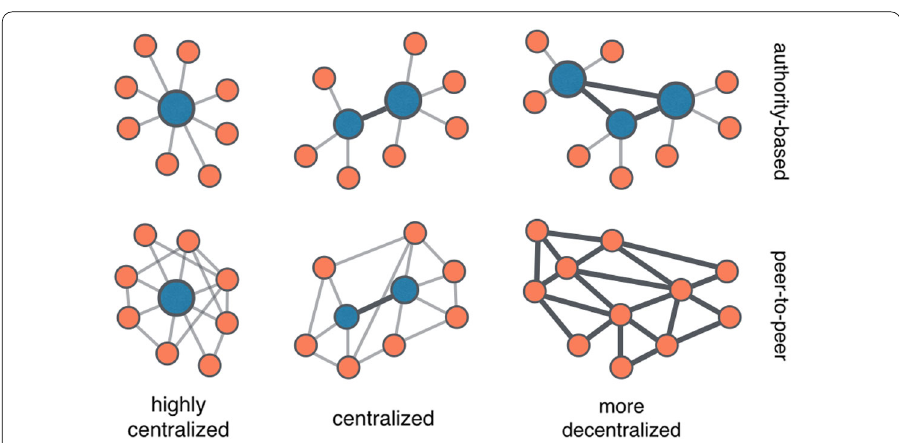
Figure 1 From centralized authorities to decentralized peer-to-peer networks. In a system based on authorities, clients connect to a central node to perform an action, like sending money to other users. This type of system can be highly centralized, with just one authority in charge for providing the service, or more decentralized, with a few interconnected authorities taking care of their clients. In a peer-to-peer